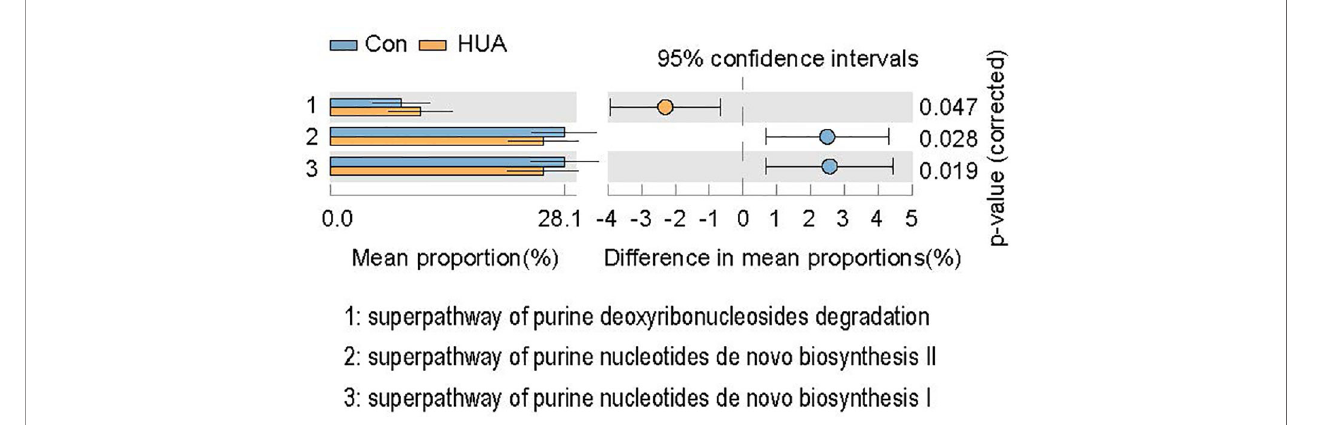
FIGURE 6 | KEGGs biomarkers of HUA and Con subjects. HUA, hyperuricemia; Con,